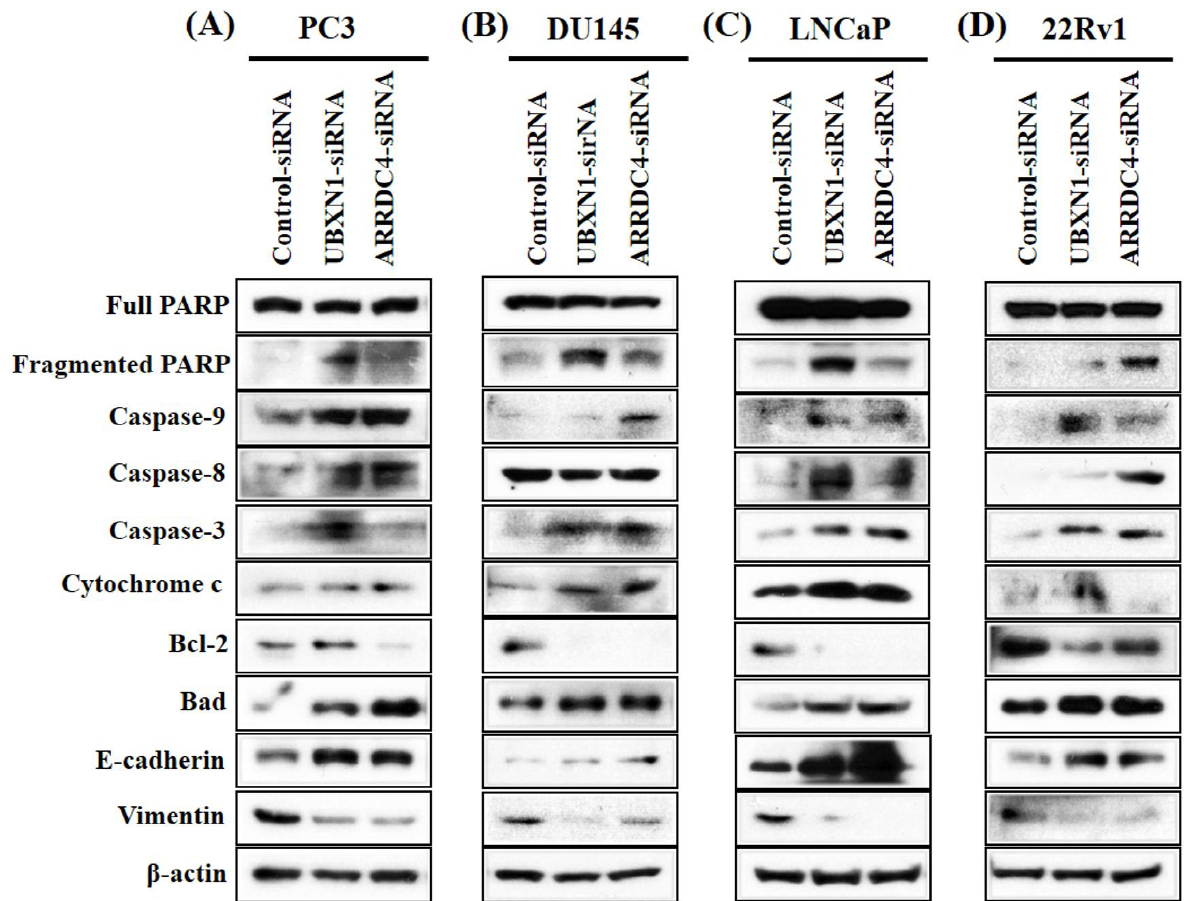
Figure 5. Knockdown of UBXN1 and ARRDC4 regulates crucial factors in apoptosis and EMT. PC3 ( A ), DU145 ( B ), LNCaP ( C ), and 22Rv1 cells ( D ) were transfected with siRNA-targeted UBXN1 and ARRDC4 or its negative control. The expression of apoptosis and EMT related protein were detected by Western blot analysis.